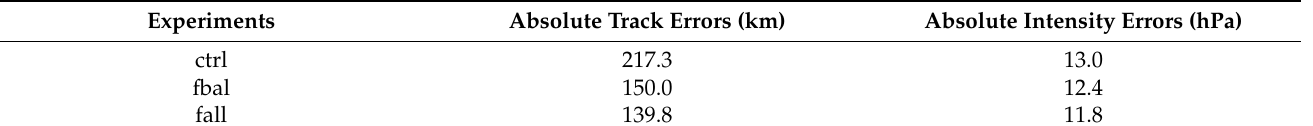
Table 3. Average track and intensity errors of all forecasts from three experiments.